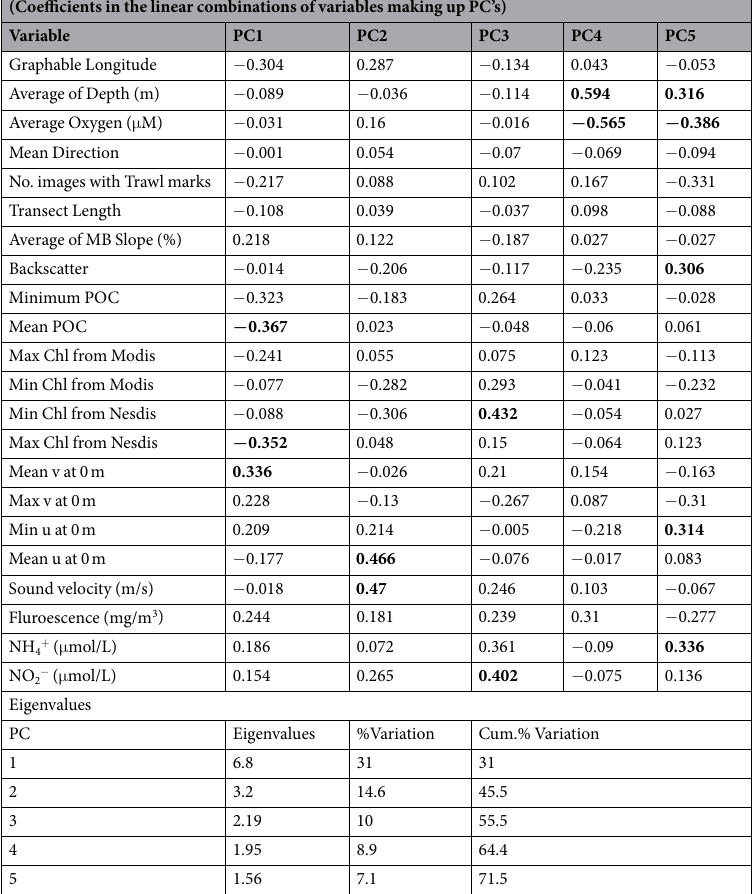
Table 3. Summary of PCA analyses of all transects. Bold indicates the highest absolute values within each PC axis. The number of variables analyzed was reduced by removing one variable from each pair with greater